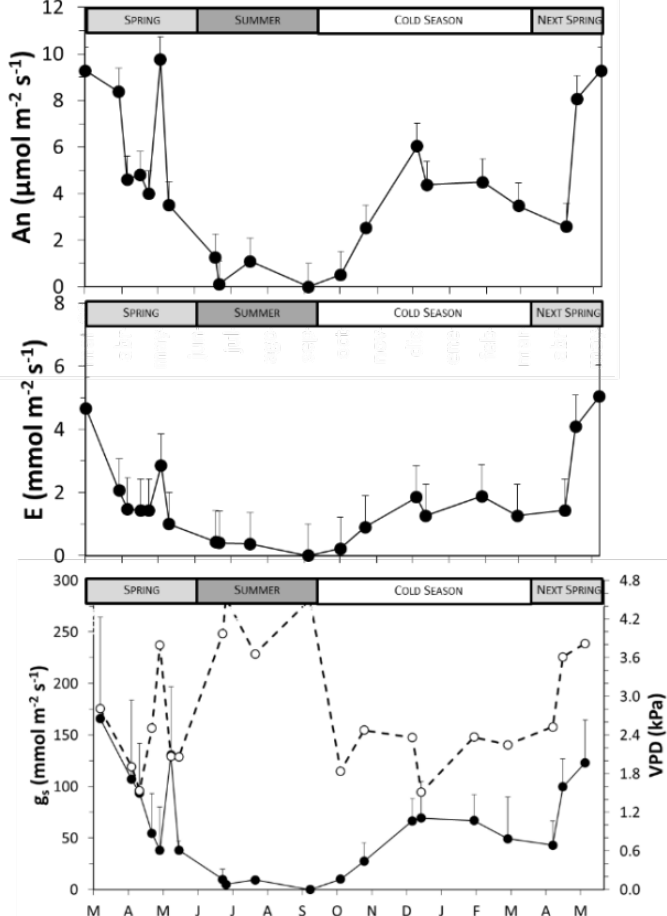
Figure 4. Seasonal course of daily net CO 2 assimilation rates (An: Top), transpiration (E: Middle) and stomatal conductance (g s : Bottom, black circles) and vapor pressure deficit (VPD: Bottom, white circles). Data are means of fifteen needle fascicles ± standard deviation measured in the